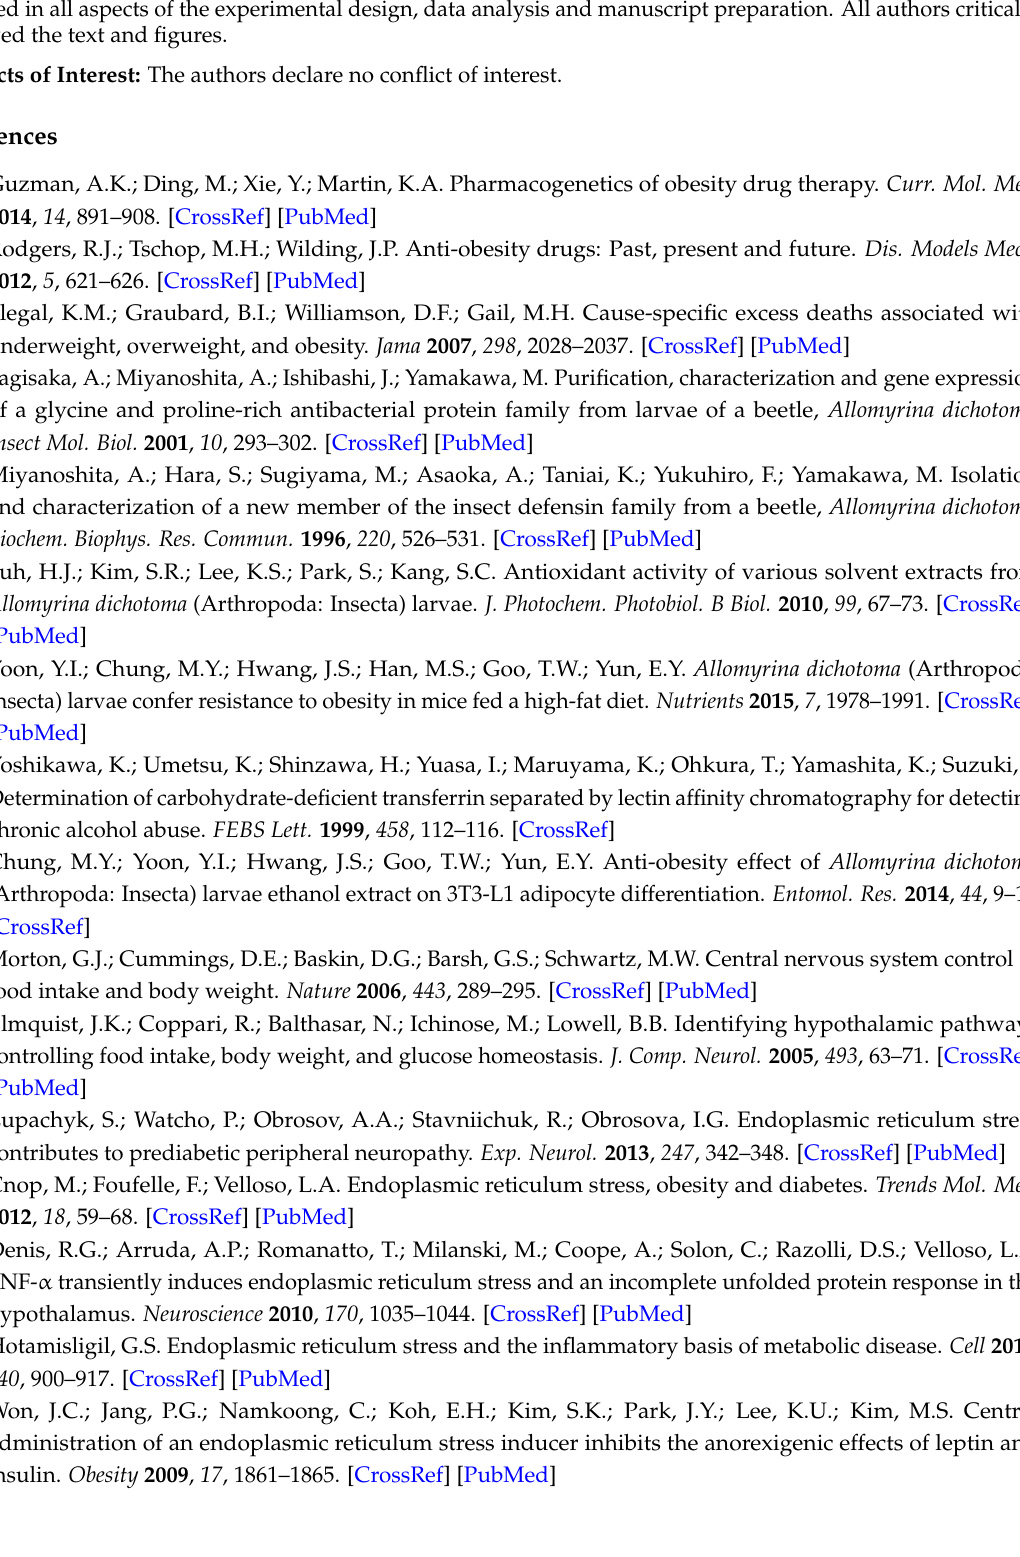
stress responsive marker expression, Figure S3: Effects of central administration of ADE on ER stress responsive markers and ER chaperone/foldases expression in mice fed a low-fat diet, Figure S4: Central administration of ADE reduces ghrelin signaling through mTOR and ERK signaling pathways in mice fed a low-fat